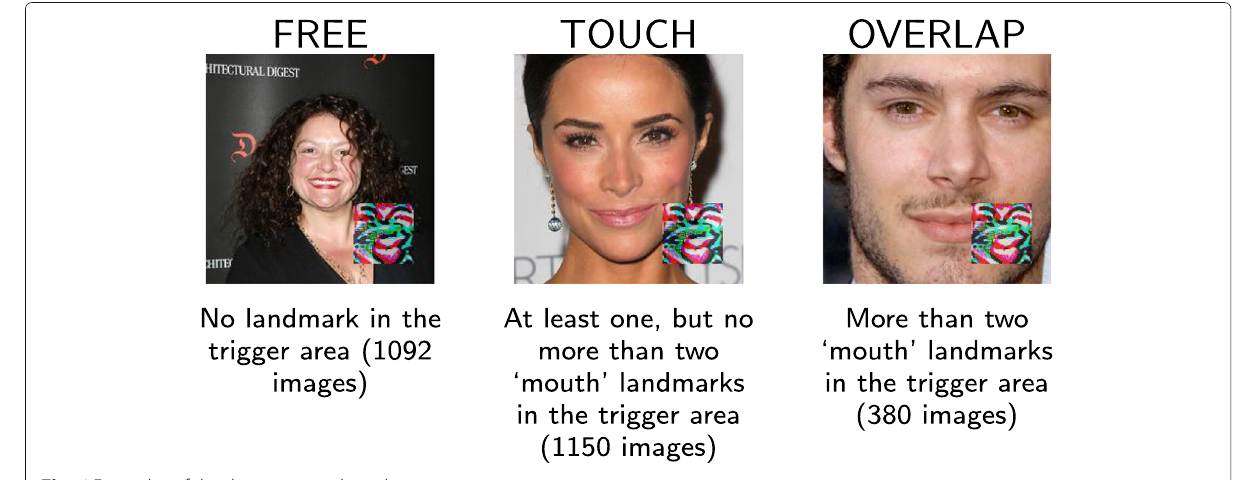
Fig. 6 Examples of the three content-based categories